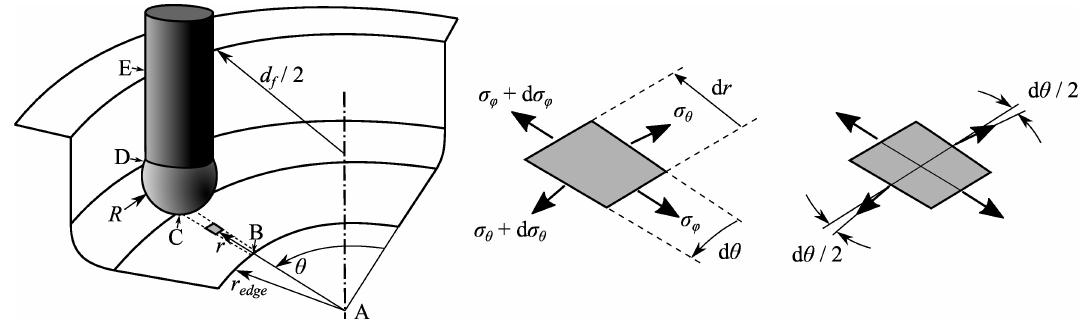
Figure 3. Membrane analysis of hole-flanging by SPIF in a single stage: schematic representation of a shell element located in the still flat zone under circumferential and radial stretching and details showing the acting